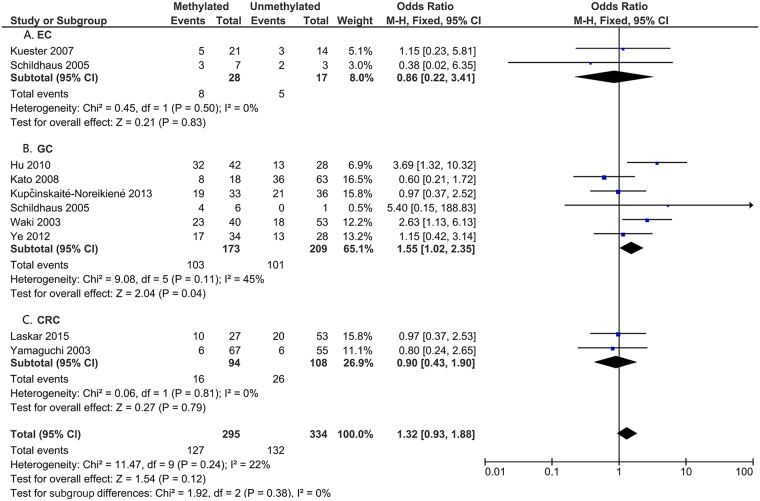
DAPK1 methylation and cancer differentiation (G3 vs. G1+G2) in: A. EC; B. GC; and C. CRC.